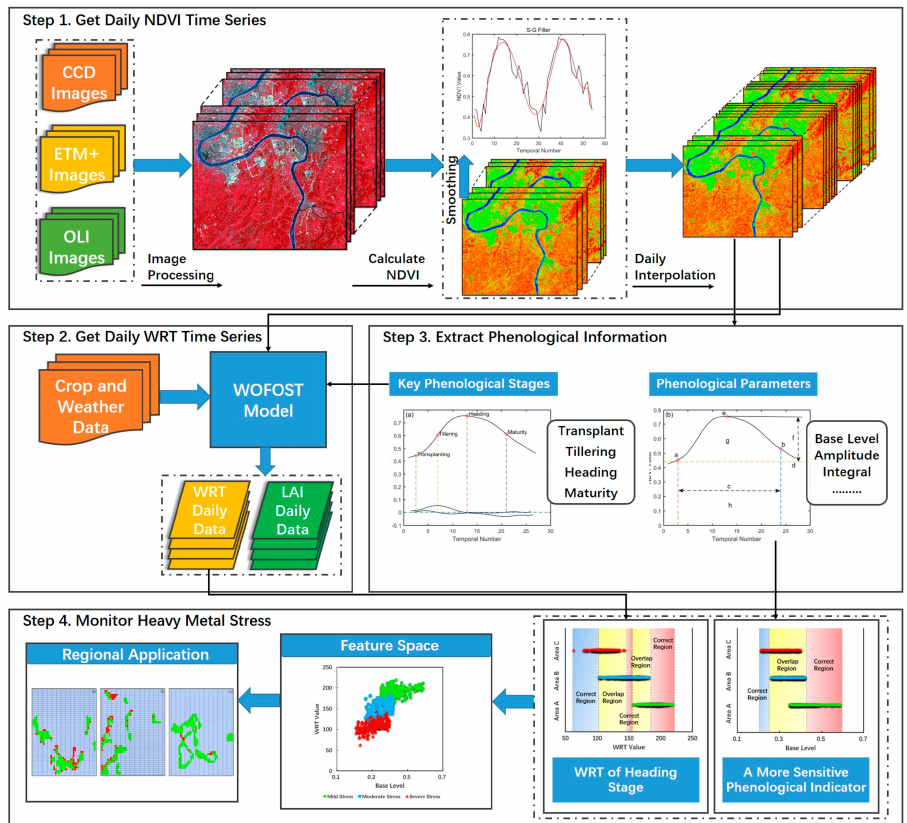
Figure 2. General flow chart for heavy metal stress monitoring in rice based on phenological analysis indicators and physiological